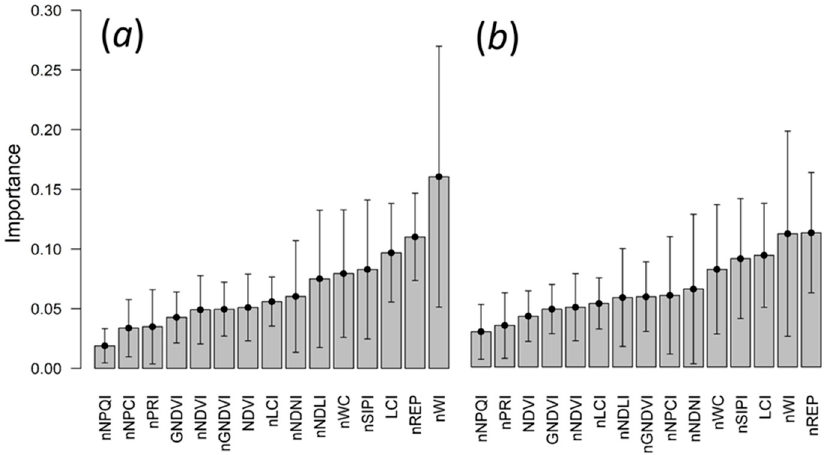
Figure 5. Overall importance of the VIs in the random forests classification for Growth 1 ( a ) and Growth 2 ( b ). The error bars indicate the standard deviation in overall importance calculated from the importance derived for the single T ∑ s.